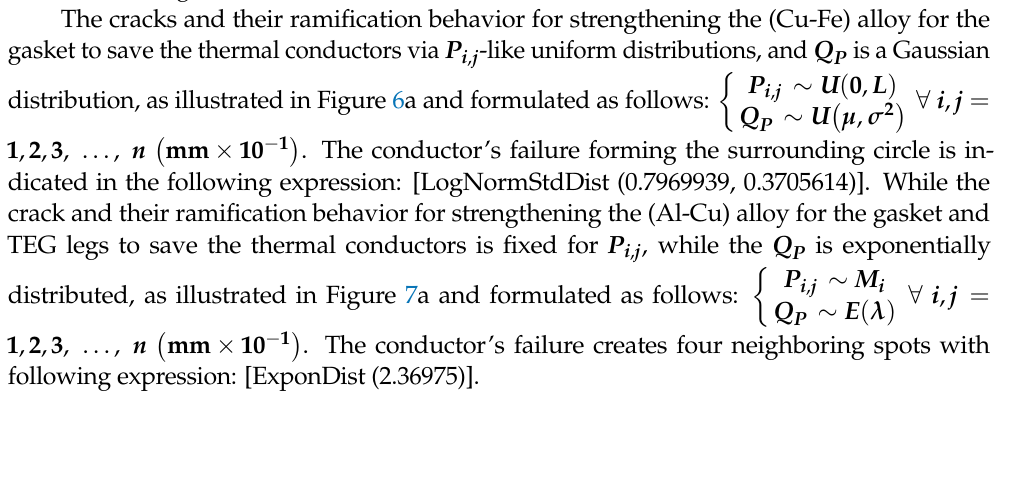
Figure 8. The change in the (Fe-Al) and (Al-Cu) alloys resistance working condition for thermal transfer.